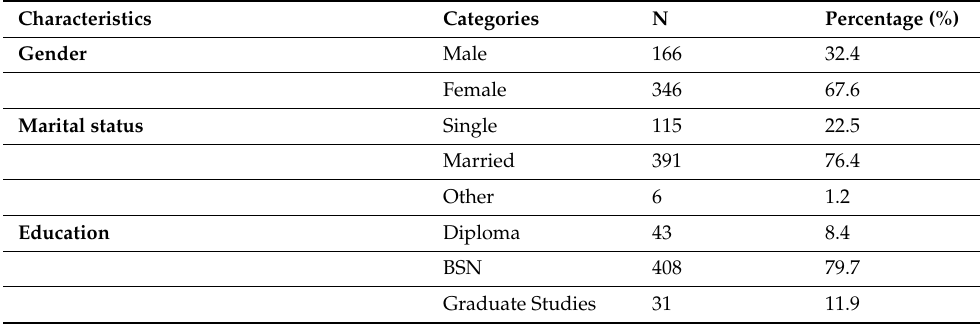
Table 1. Demographics of the